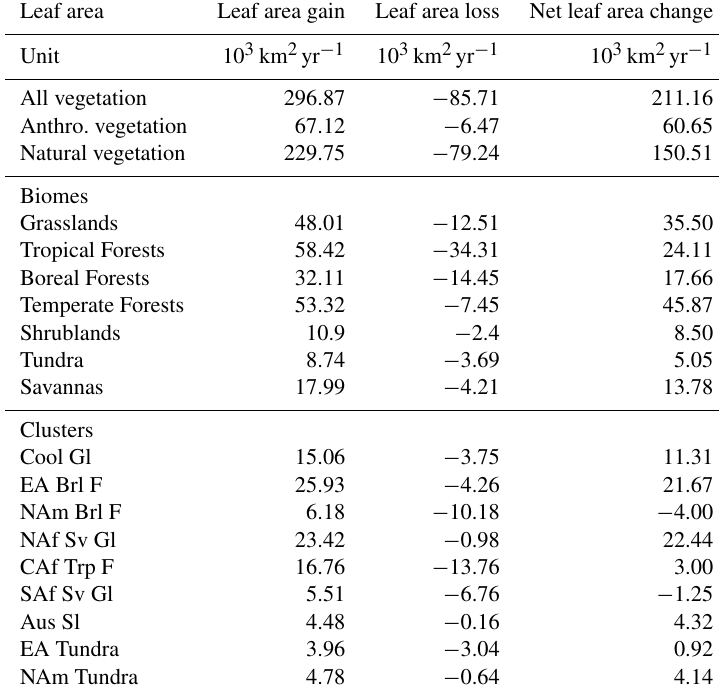
Table 2. Leaf area gain, loss, and net change for different biomes and prominent clusters of change for the time period 1982–2017. Significant changes are determined by the means of the Mann–Kendall significance test ( p < 0 . 1). The abbreviations used to describe the different clusters are explained in “Materials and